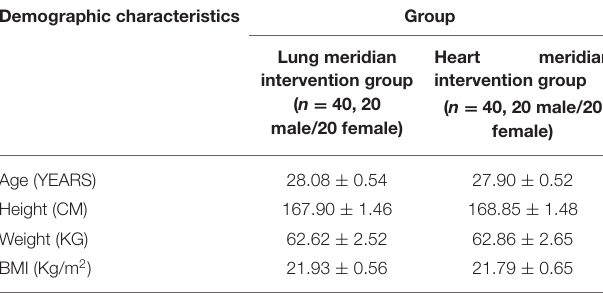
TABLE 1 | Demography characteristics of participants in experiments (mean ±